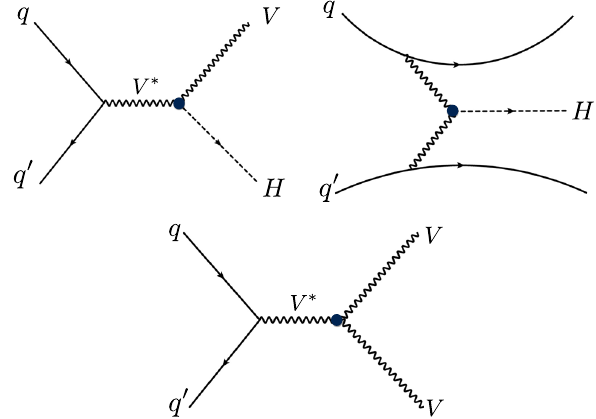
Fig. 4 RepresentativeFeynmandiagramsfortheconsideredHiggsand weak-boson production mechanisms, namely for V H associated pro- duction (left), VBF Higgs-boson production (center) and diboson pro- duction